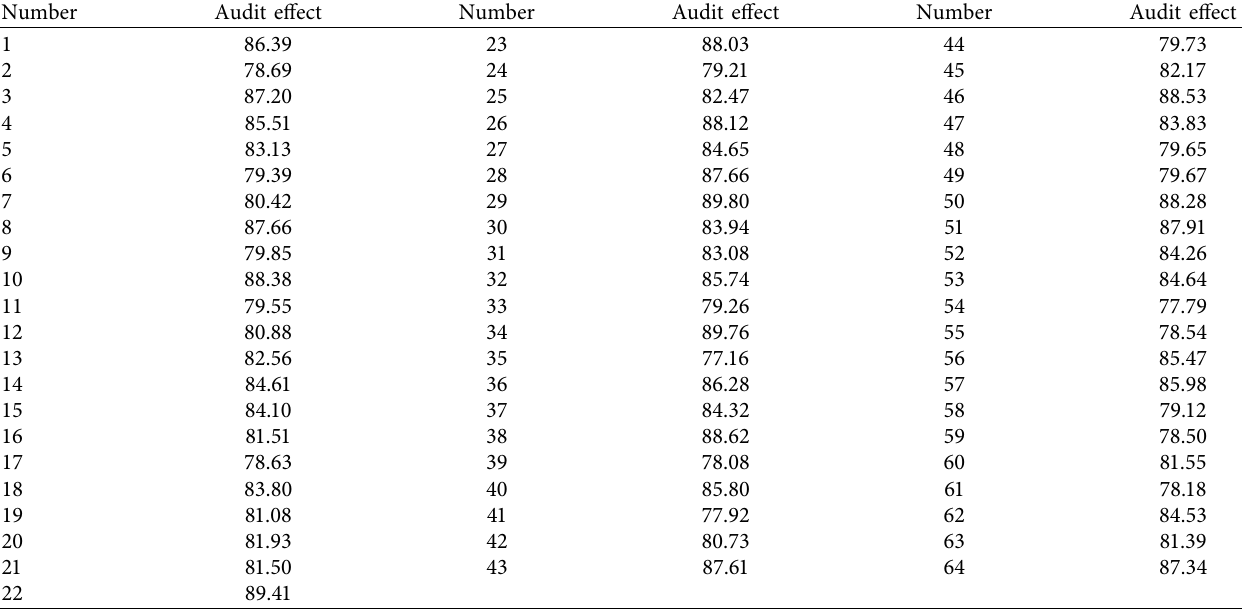
Table 2: Auditing effect of financial